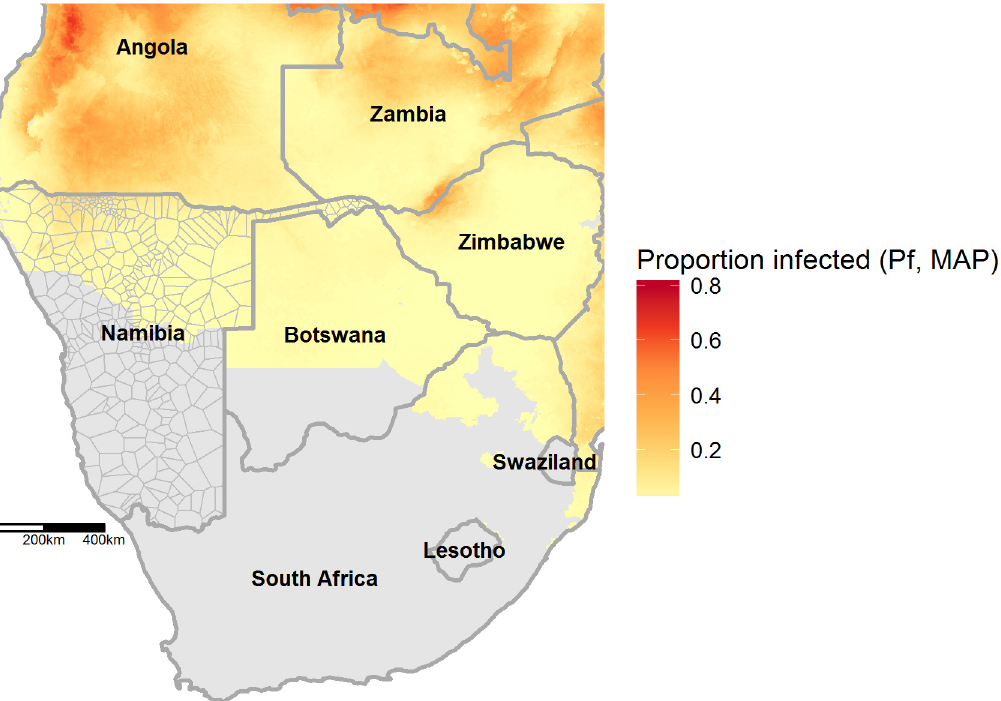
Fig 3. Regional map with parasite rate estimates from [10]. Plasmodium falciparum parasite rate ( Pf PR) shown in yellow and red; grey areas indicate areas with no malaria or areas where predicted annual incidence is less than 1 per thousand people ( Pf PR surface adapted from [10]). National borders obtained from thematicmapping.org, and are available for use under a Creative Commons BY-SA